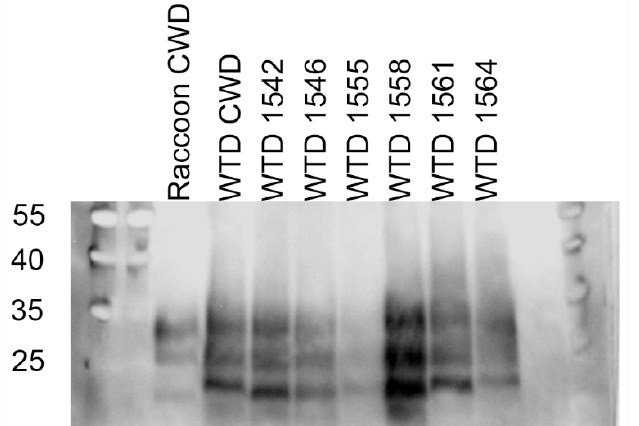
Figure 7. Western blots probing for PrP Sc . Raccoon CWD and white-tailed deer inoculated with raccoon CWD (1542, 1546, 1555, 1558, 1561, 1564) had smaller unglycosylated PrP Sc fragments (lower/further migration) compared to chronic wasting disease straight from a GG96 white-tailed deer (WTD CWD). Gel loading tissue equivalents left to right (mg): 8, 1, 1, 2, 3, 2, 1.5, 4. Molecular weights are displayed in kDa. Immunostaining for PrP Sc was performed with monoclonal antibody SHA31.